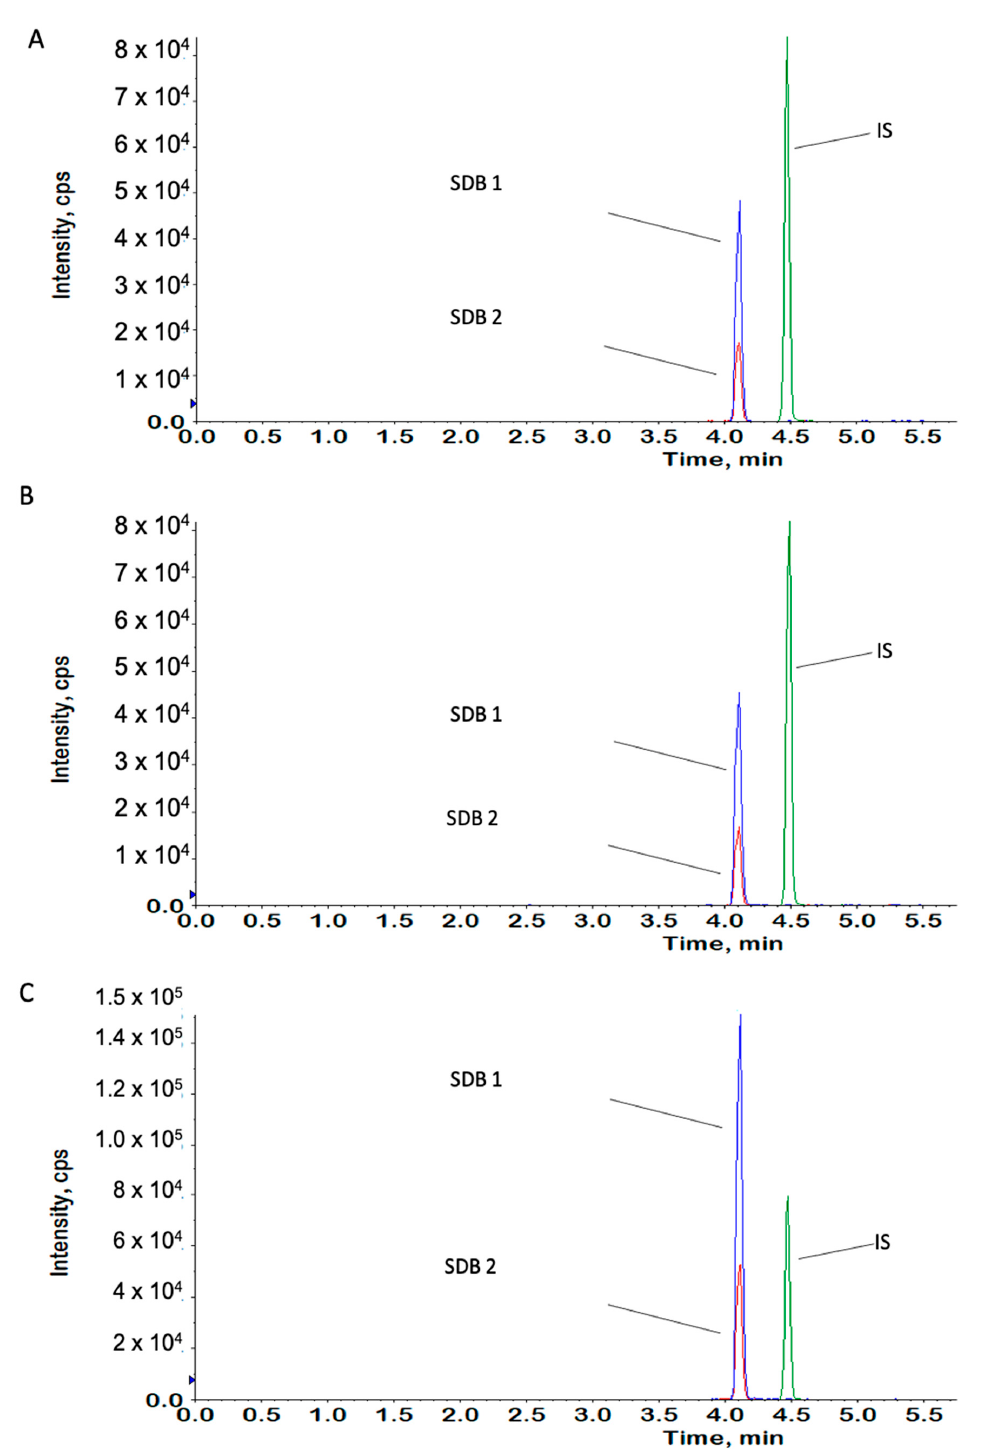
Figure 10. Analysis of hydrogen sulfide (H 2 S) in rat brain structures using LC-MS/MS. Chromatograms obtained from ( A ) blank rat brain homogenate, spiked with SDB, at a concentration of 800 nM, ( B ) hippocampus homogenate of a rat from the SHAM group—calculated H 2 S concentration = 844 nM and ( C ) the same hippocampus homogenate of a rat from the SHAM group pretreated with DTT—calculated H 2 S concentration = 2600 nM. SDB 1: m / z = 415/193 and SDB 2: m / z = 415/223.